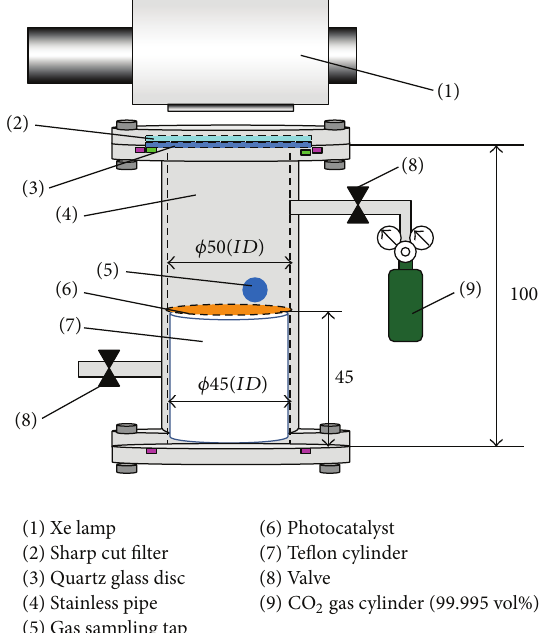
Figure2:SchematicdrawingofCO 2 reductionexperimentalset-up.